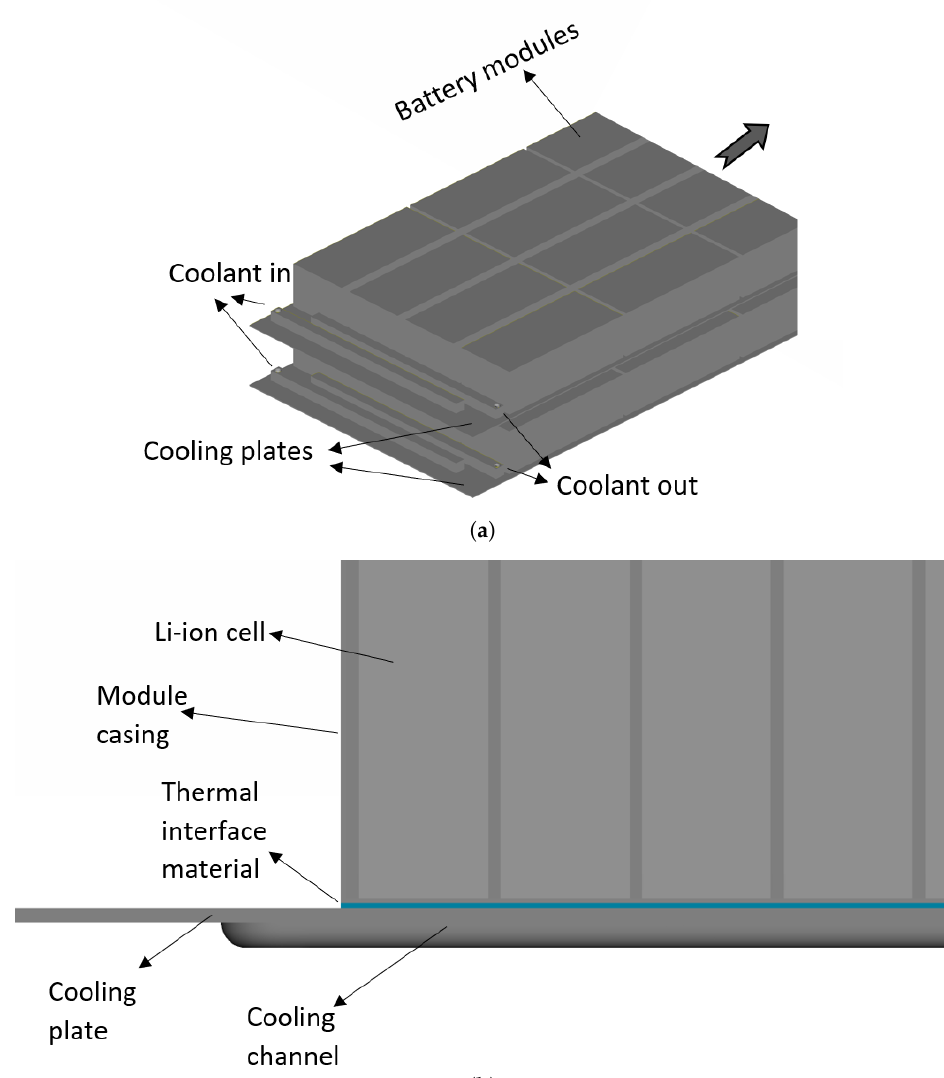
Figure 1. 3D representation of the battery pack: ( a ) isometric view; ( b ) Cross-sectional view of the module